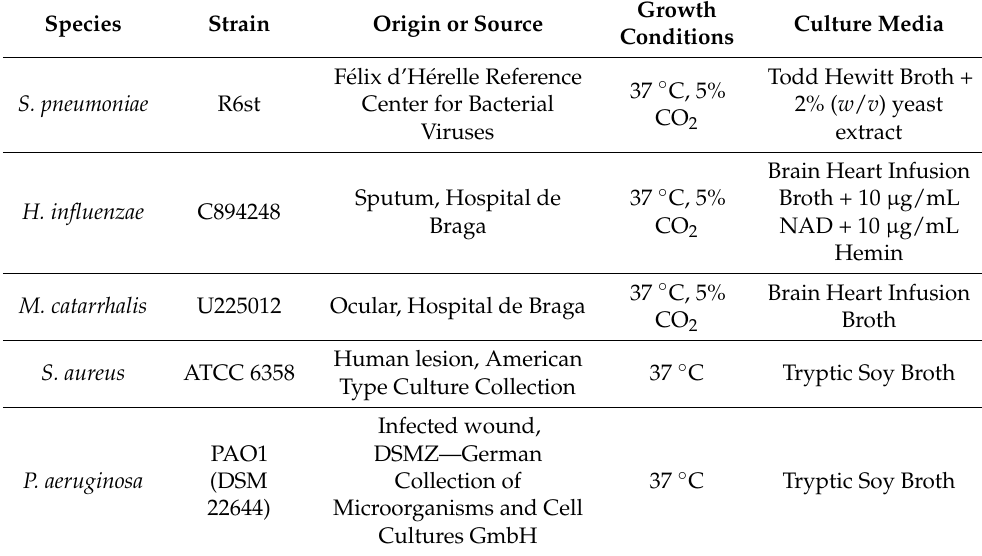
Table 1. Bacterial strains and growth conditions.